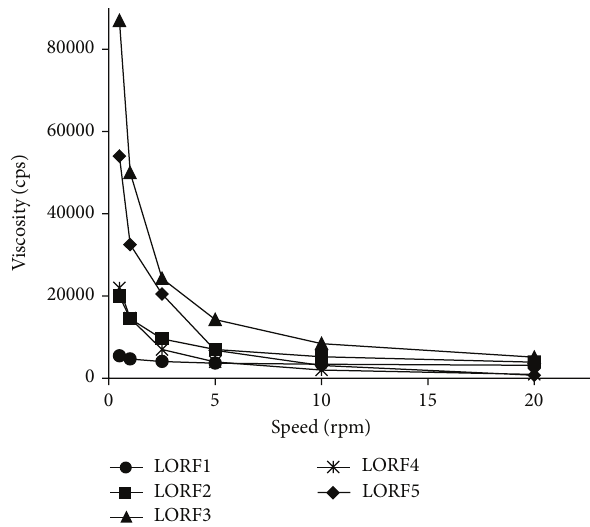
Figure 2: Effect of shear rate on the viscosity of different gel formulations.